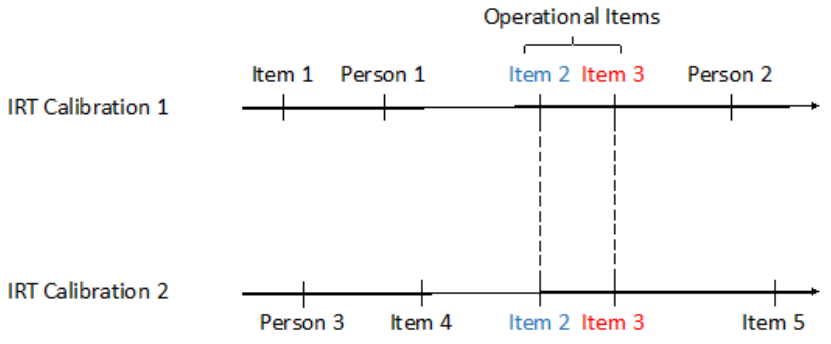
Figure 3. Illustration of fixed-parameter calibration